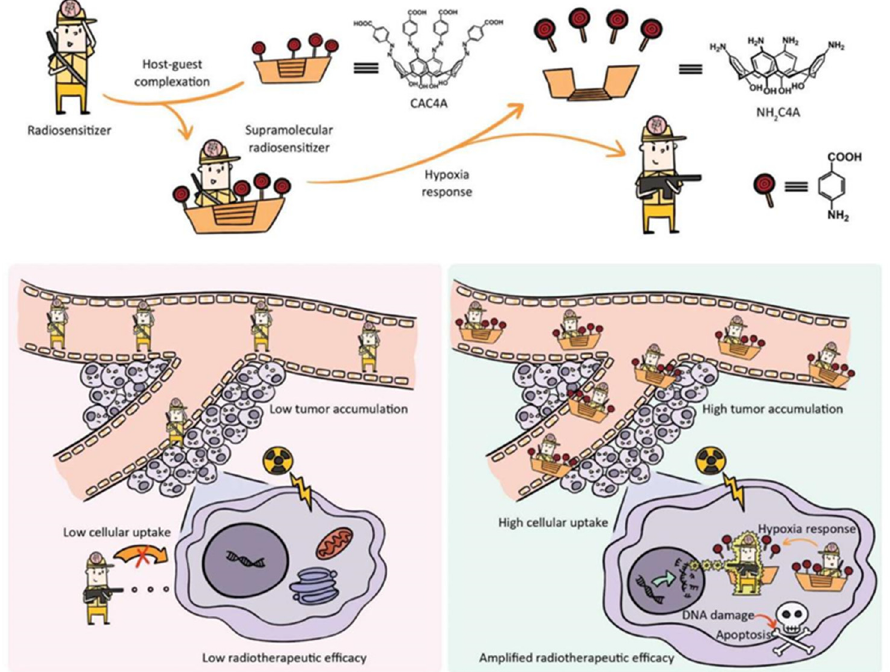
Figure 14. Schematic illustration of the supramolecular radiotherapy strategy based on host–guest chemistry and the corresponding enhanced radio therapeutic efficiency mechanism (reproduced with the permission of John Wiley & Sons, Inc. from ref. [85]).